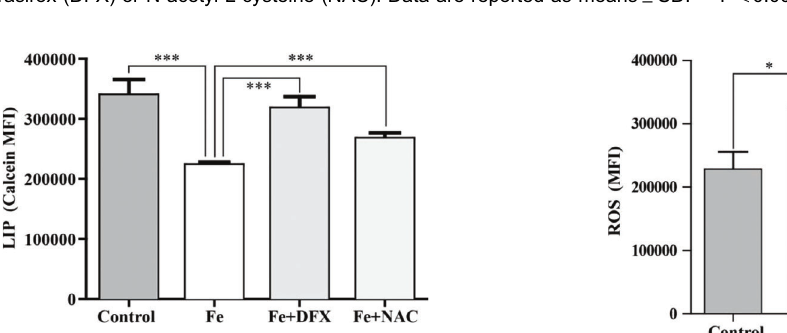
Figure 2. Flow cytometric pro fi le of Lin-Sca-1 + c-kit (LKS) – hematopoietic progenitor cells (HPCs) and LKS + hematopoietic stem cells (HSCs) cells ( A ). Decreased ratio of HPCs ( B ) and HSCs ( C ) in iron overload (Fe) bone marrow mononuclear cells (BMMNCs) reversed by deferasirox (DFX) or N-acetyl-L-cysteine (NAC). Data are reported as means ± SD. ***P o 0.001 (ANOVA).